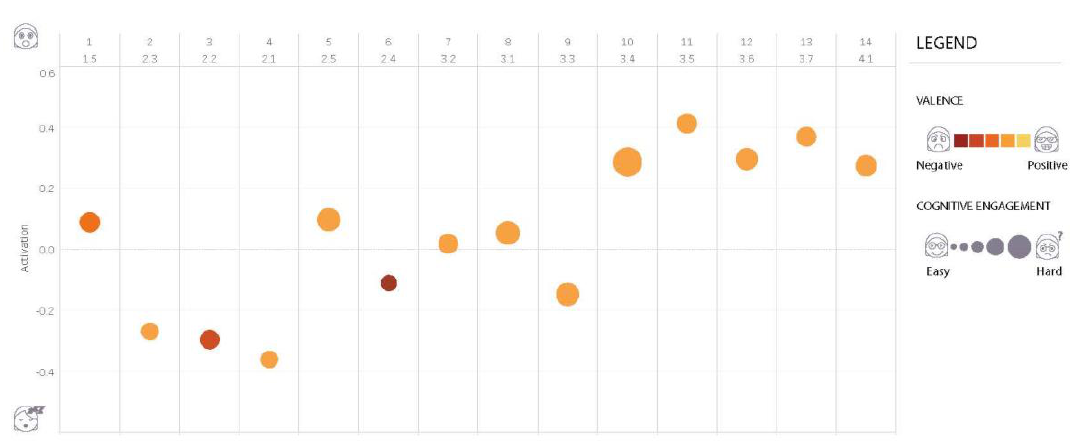
Figure 9. Visual representation of the three physiological aspects of user’s experience (cognitive engagement, valence and arousal.